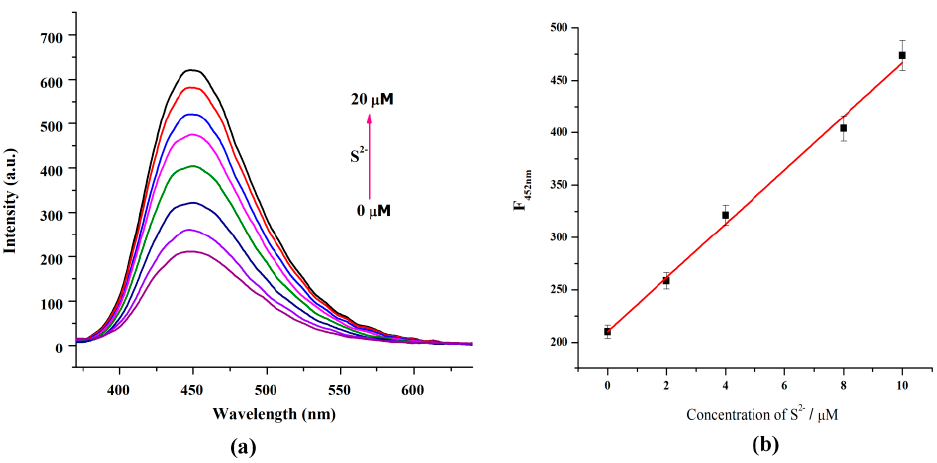
Figure 7. ( a ) FL response of the FCD–Cu 2+ system (20 µ M of Cu 2+ in dilute FCD dispersion) upon the addition of S 2 − (0–20 µ M, λ ex = 320 nm). ( b ) Plot of FL intensity of FCD–Cu 2+ against S 2 − concentration, λ ex = 320 nm, λ em = 452 nm.